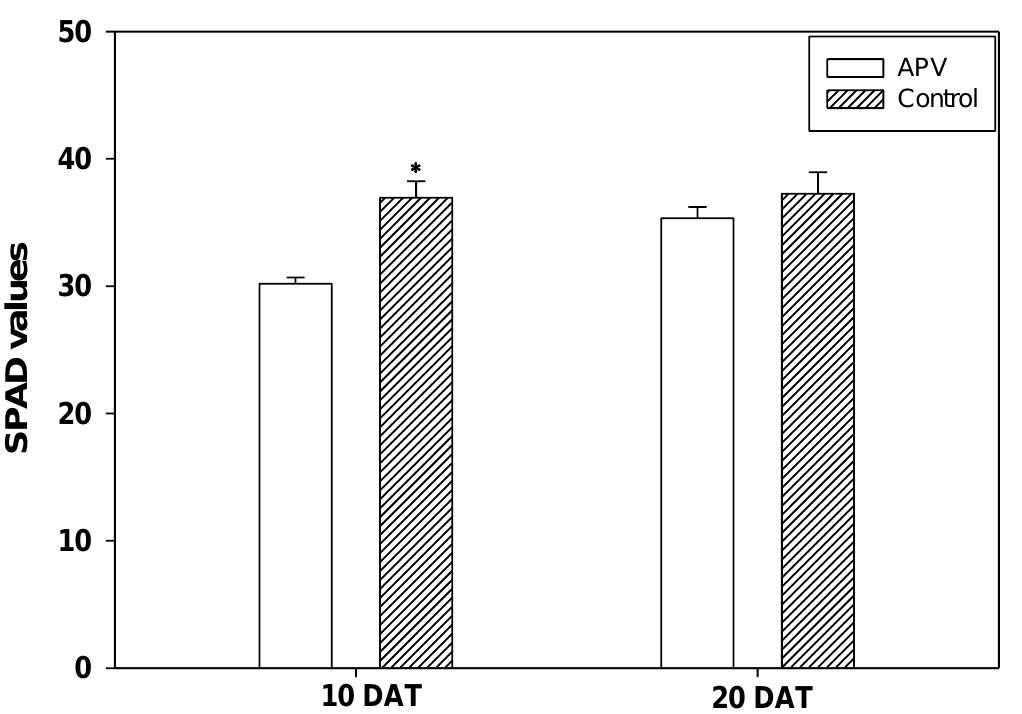
Figure 5. SPAD values of rice plants at 10 and 20 days after transplanting (DAT) underneath an agrophotovoltaic (APV) system, Seungju, South Korea. Error bars represent standard deviation. * significantly different between APV system and control plot at different investigation dates using a t -test ( p = 0.05).